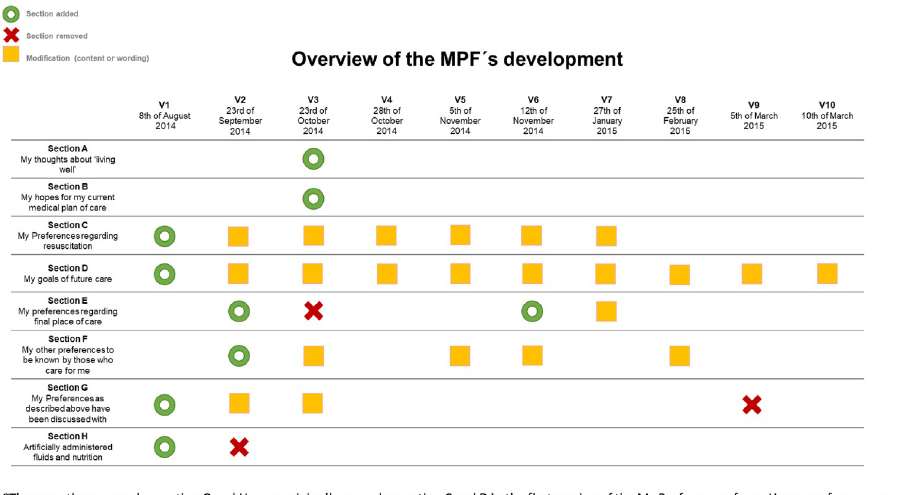
Fig 1. Overview of the thematic development of the My Preferences Form